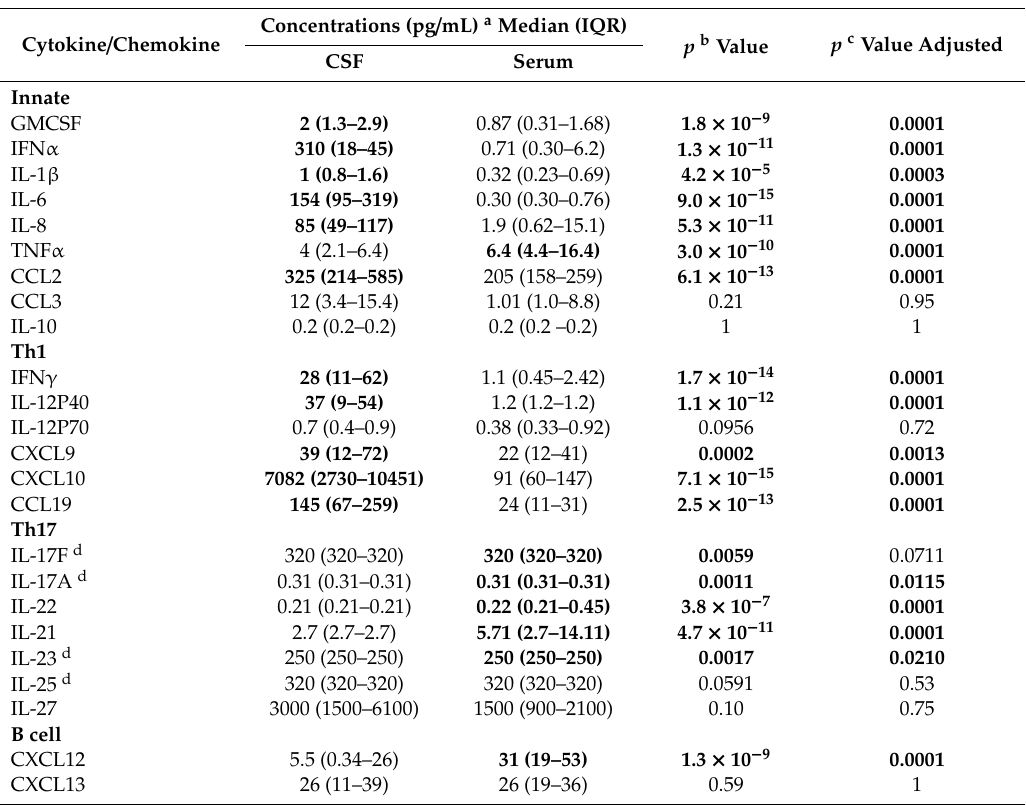
Table 2. Cerebrospinal Fluid and Serum Concentrations of Cytokines / Chemokines Obtained in Patients During Meningoencephalic Phase of Tick-borne